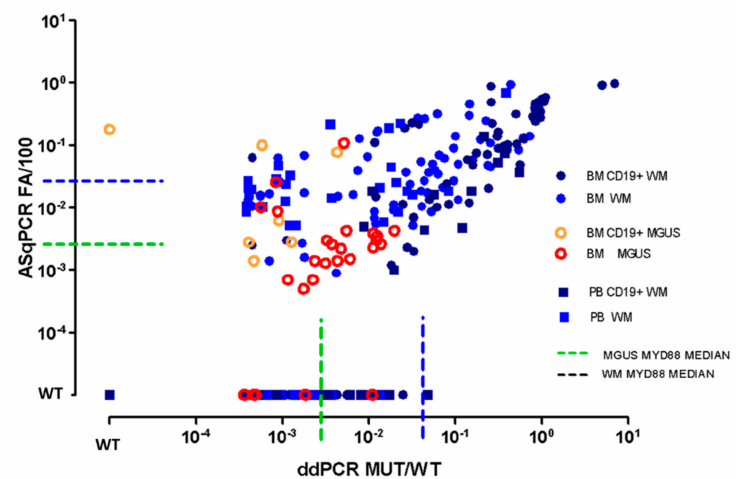
Figure 1. ASqPCR vs. ddPCR. Comparison between ASqPCR and ddPCR for MYD88 L265P de- tection in terms of ratio between MUT and WT. BM: bone marrow; PB: peripheral blood; MGUS: IgM-monoclonal gammopathy of undetermined significance; WM: Waldenström; WT: Wildtype (quantitative value outside the limit of blank. Limit of blank was calculated based on healthy subjects as the mean value +1 SD); 10 − 4 : 1 × 10 − 4 .